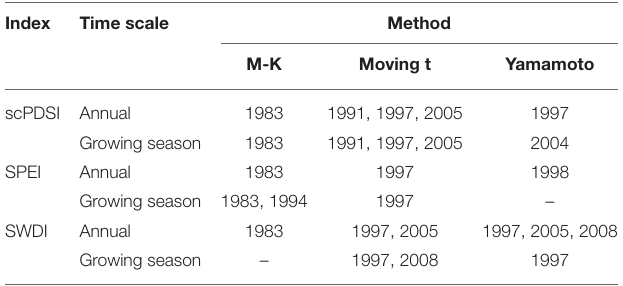
TABLE 2 | Results of abrupt change detection for three drought indices at annual and growing season scales.